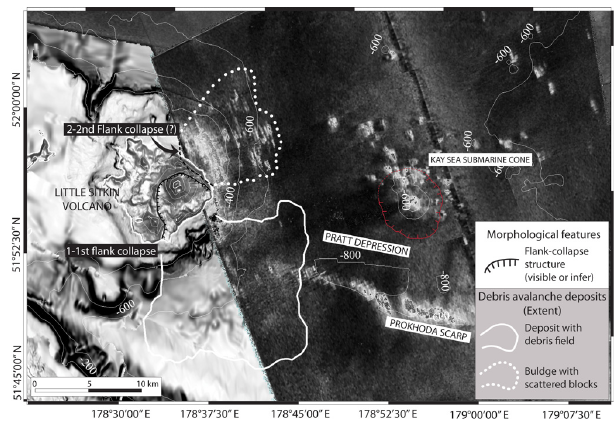
Fig. 5. Topography, bathymetry and Gloria side-scan data of Little Sitkin island. The image displays large debris slide deposits around the island and Kay Sea submarine cone (Snyder, 1957). For side scan data the black is high backscatter and white is low backscatter. Contour interval is